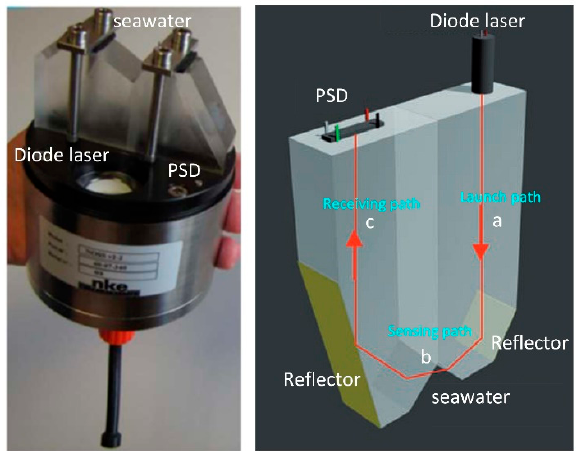
Figure 3. Principle and physical diagram of the RI salinity sensor from NKE, France [23].